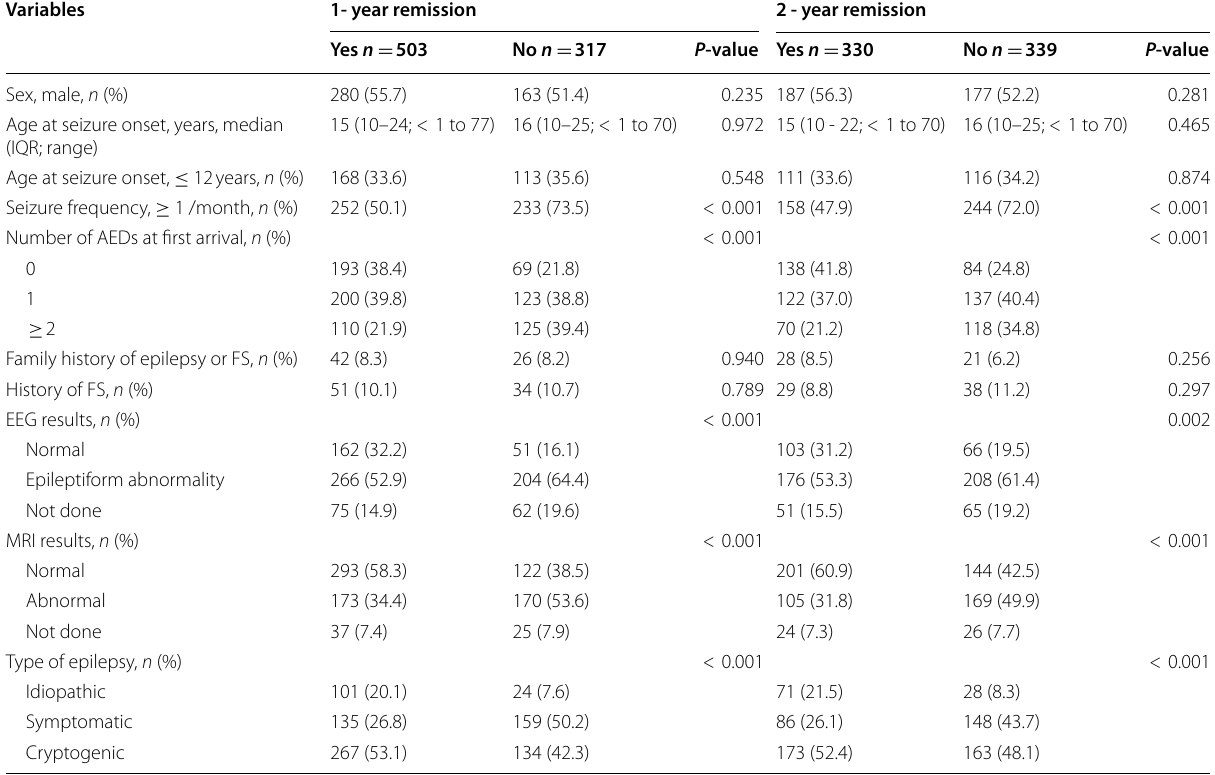
FS febrile convulsions